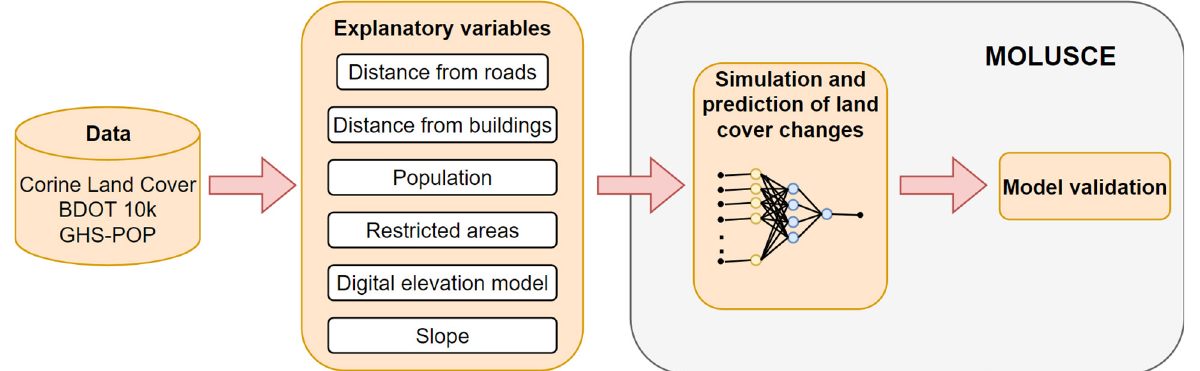
Fig. 2. Workflow scheme of land-use prediction